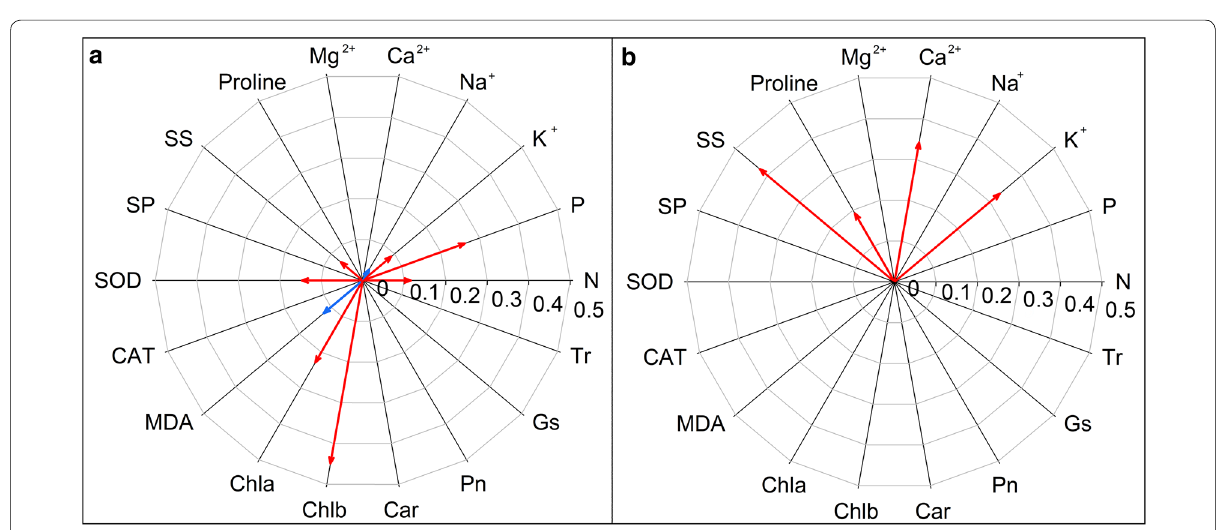
Fig. 6 Relationships between the effect size of total biomass and the effect sizes of other physiological indicators for glycophytes ( a ) and halophytes ( b ) under salt stress conditions. Red arrows indicate positive relationships. Blue arrows indicate negative relationships. The arrow length indicates the value of R